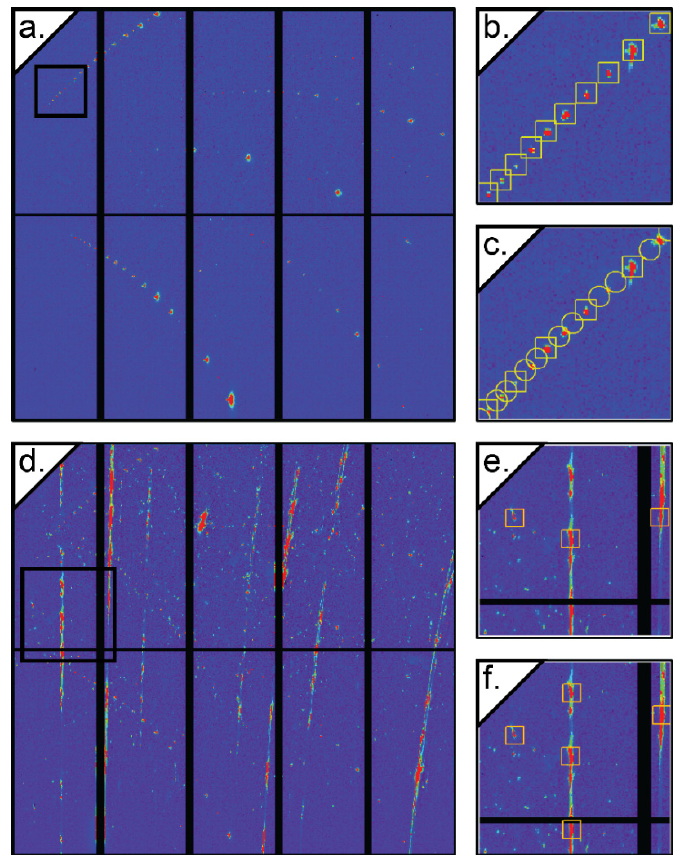
Figure 6. ( a ). This pattern is representative of the SiC2 sample in the 4H-SiC-indexed region. ( b ). The yellow squares indicate peaks that were identified and indexed as 4H-SiC. All peaks can be fit with this unit cell. ( c ). The same pattern from a. is indexed as 6H-SiC. The yellow circles show peaks that are predicted to occur, but are not found (with signal-to-noise ratio > 5). ( d ). This pattern is representative of the polycrystalline region of the SiC2 sample ( e ) and ( f ). are representative fits to the 4H- and 6H-SiC unit cells, respectively. Boxes in ( a ). and ( d ). outline enlarged areas from ( b )., ( c )., ( e ) and ( f ). A native Si inclusion was initially identified by visual inspection due to di ff erences in its reflectivity relative to the surrounding SiC. This inclusion occurs within the mixed 4H- / 6H-SiC region of